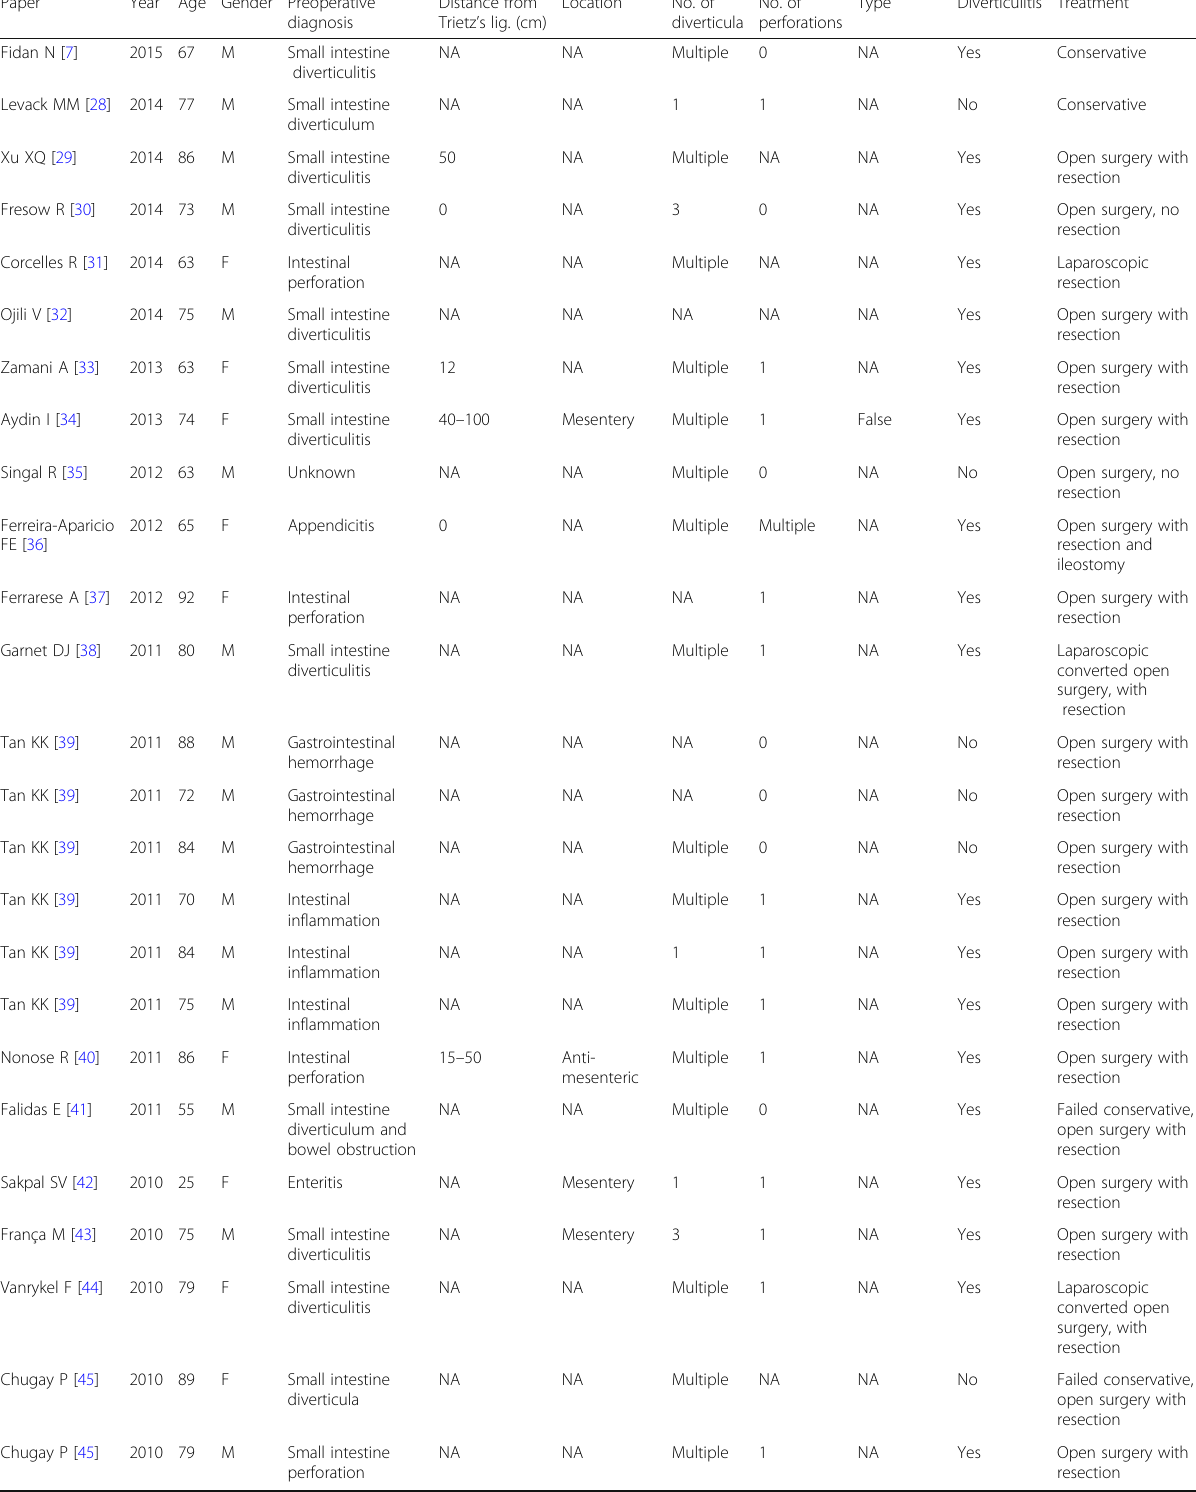
Table 1 Characteristics and treatment of jejunal diverticulosis in cases published between 2010 and 2020 (Continued)